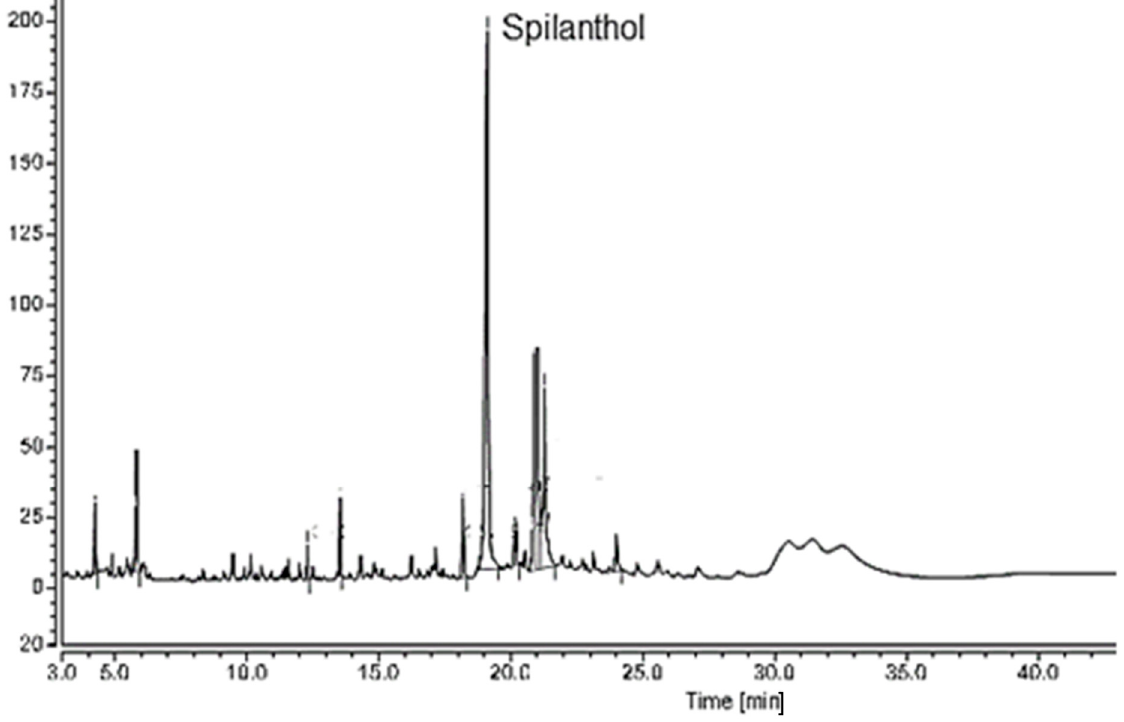
Figure 1. GC-FID chromatogram obtained by the flow of jambu flowers. The chromatogram shows that spilanthol presented the most prominent peak com- pared to other components, representing 39.73% of the total extract content, and had